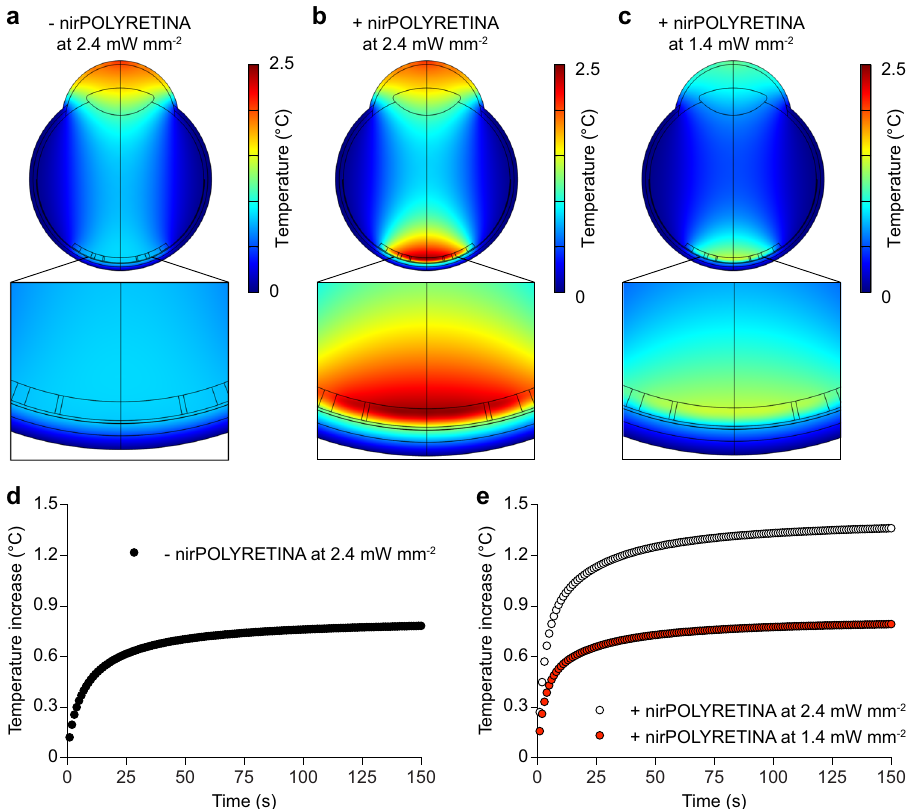
Fig. 8 Thermal simulations. a Temperature increase in the modelled eye after 150 s of continuous illumination (730 nm, 2.4 mWmm − 2 ). The insert shows a larger view of the modelled retina. b , c Temperature increase in the modelled eye with nirPOLYRETINA after 150 s of continuous illumination at 2.4 mW mm − 2 (730 nm, b ) and at 1.4 mWmm − 2 (730nm, c ). The inserts show a larger view of the modelled retina and nirPOLYRETINA. d , e Time courses of the temperature increase in the modelled retina during 150 s of continuous illumination without nirPOLYRETINA at 2.4 mW mm − 2 (730nm, black circles), with nirPOLYRETINA at 2.4 mW mm − 2 (730 nm, white circles), and with nirPOLYRETINA at 1.4 mWmm − 2 (730nm, red